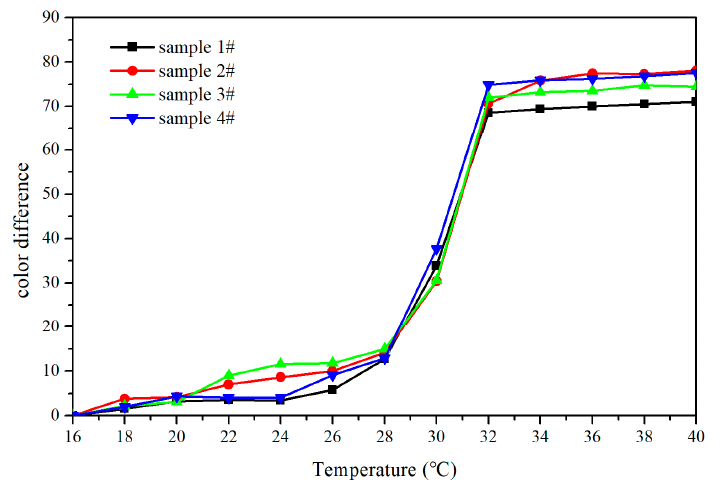
Figure 1. The color difference of topcoats with fluorane microcapsules under different tempera- tures.